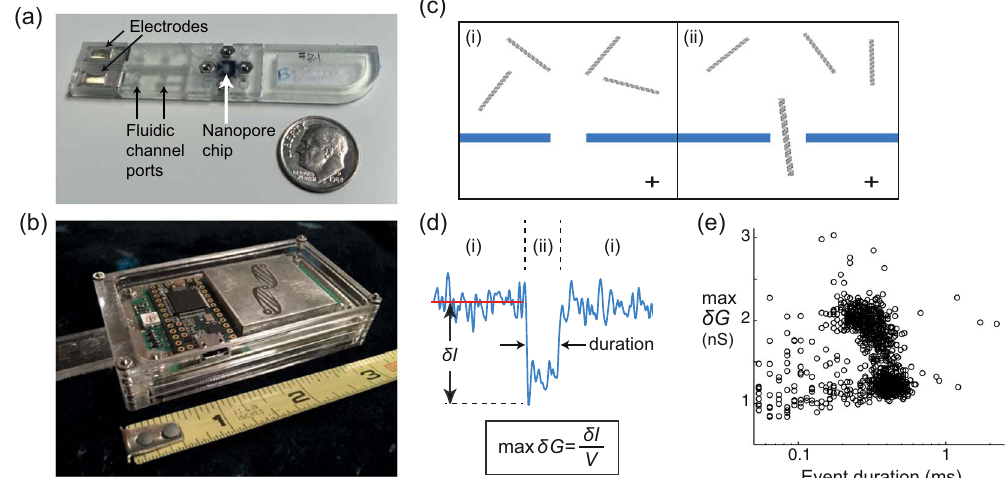
Figure 1. Single-molecule sensing by inserting a disposable strip into a USB-enabled mobile device. ( a ) The 3D printed strip houses the fluidics and nanopore chip (Supplementary Fig. S1). Replaceable Ag/AgCl electrodes connect the fluidic channels with the circuitry in the reader device. Reagents and buffer are loaded into one channel, with buffer only in the other channel. ( b ) The strip is inserted into the handheld device that houses voltage-clamp circuitry, which supplies a voltage across the pore and measures ionic current through the pore. Data transfer is through a USB port for event detection and analysis on a PC or laptop (Supplementary Figs S3 and S4). ( c ) Schematic of diffusing DNA above the nanopore on the reagent-added side, during (i) an open nanopore period, and (ii) passage of a single DNA through the pore into the voltage-positive side. ( d ) A representative electrical current event caused by a single dsDNA passing through a nanopore, annotating (i) the open pore periods and (ii) the passage duration. Events are quantified by the passage duration and the maximum conductance depth (max δ G = δ I / V , V = 0.1 V). ( e ) An all-event scatter plot of max δ G